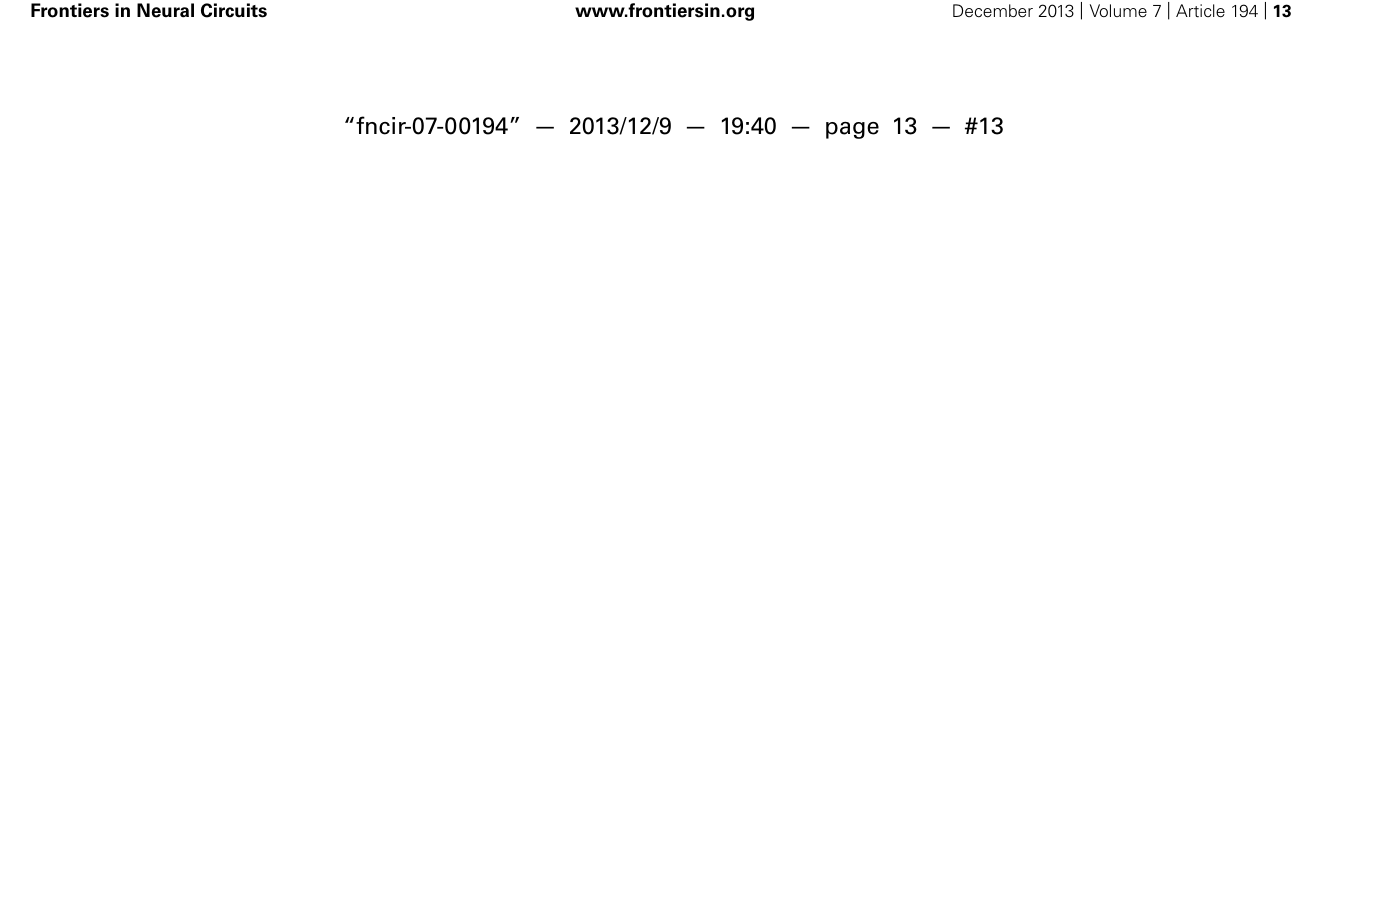
neuron for the same parameter values as in Figure 6A1